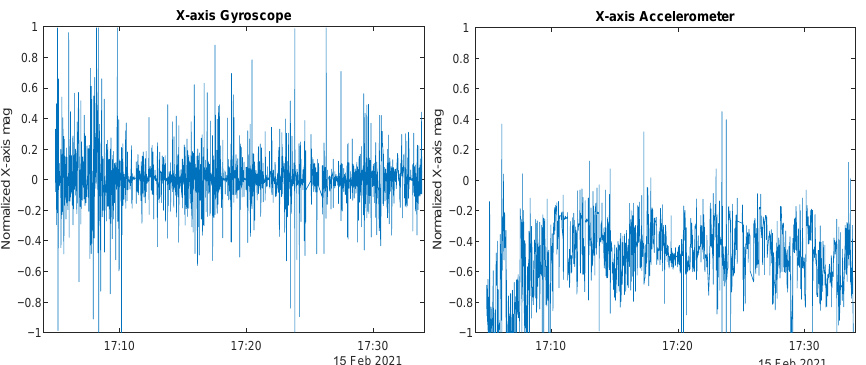
Figure 3. Example fragment of X -axis Gyroscope and Accelerometer signals recorded from the MA sensor during a test